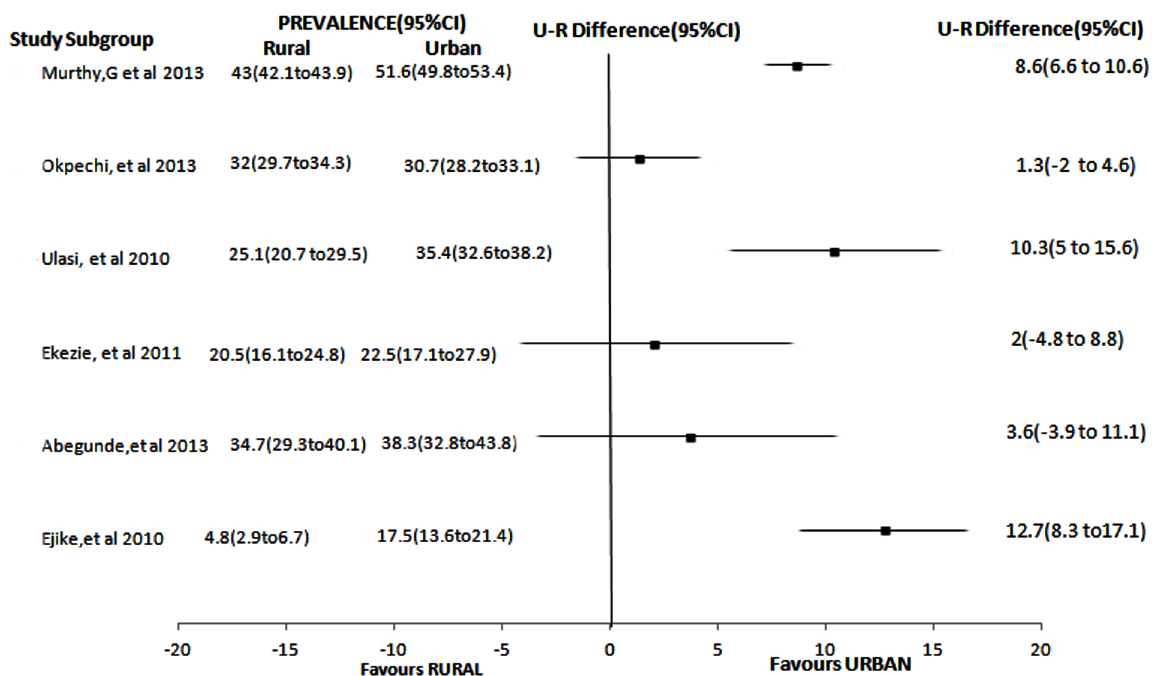
Fig 4. Forest Plot showing U-R difference of prevalence of hypertension in studies comparing rural and urban populations. U-R difference = Urban- Rural difference